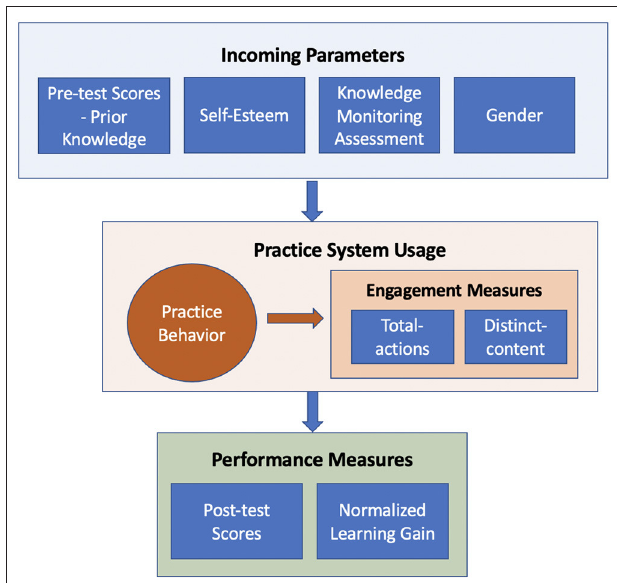
FIGURE 2 | An overview of key measures used in the study. We explored possible connections between learners’ individual differences (i.e., incoming parameters) collected at the start of the learning process, practice behavior, performance and engagement measures. We used practice system usage logs to model practice behavior of learners and constructed a data-driven model of individual